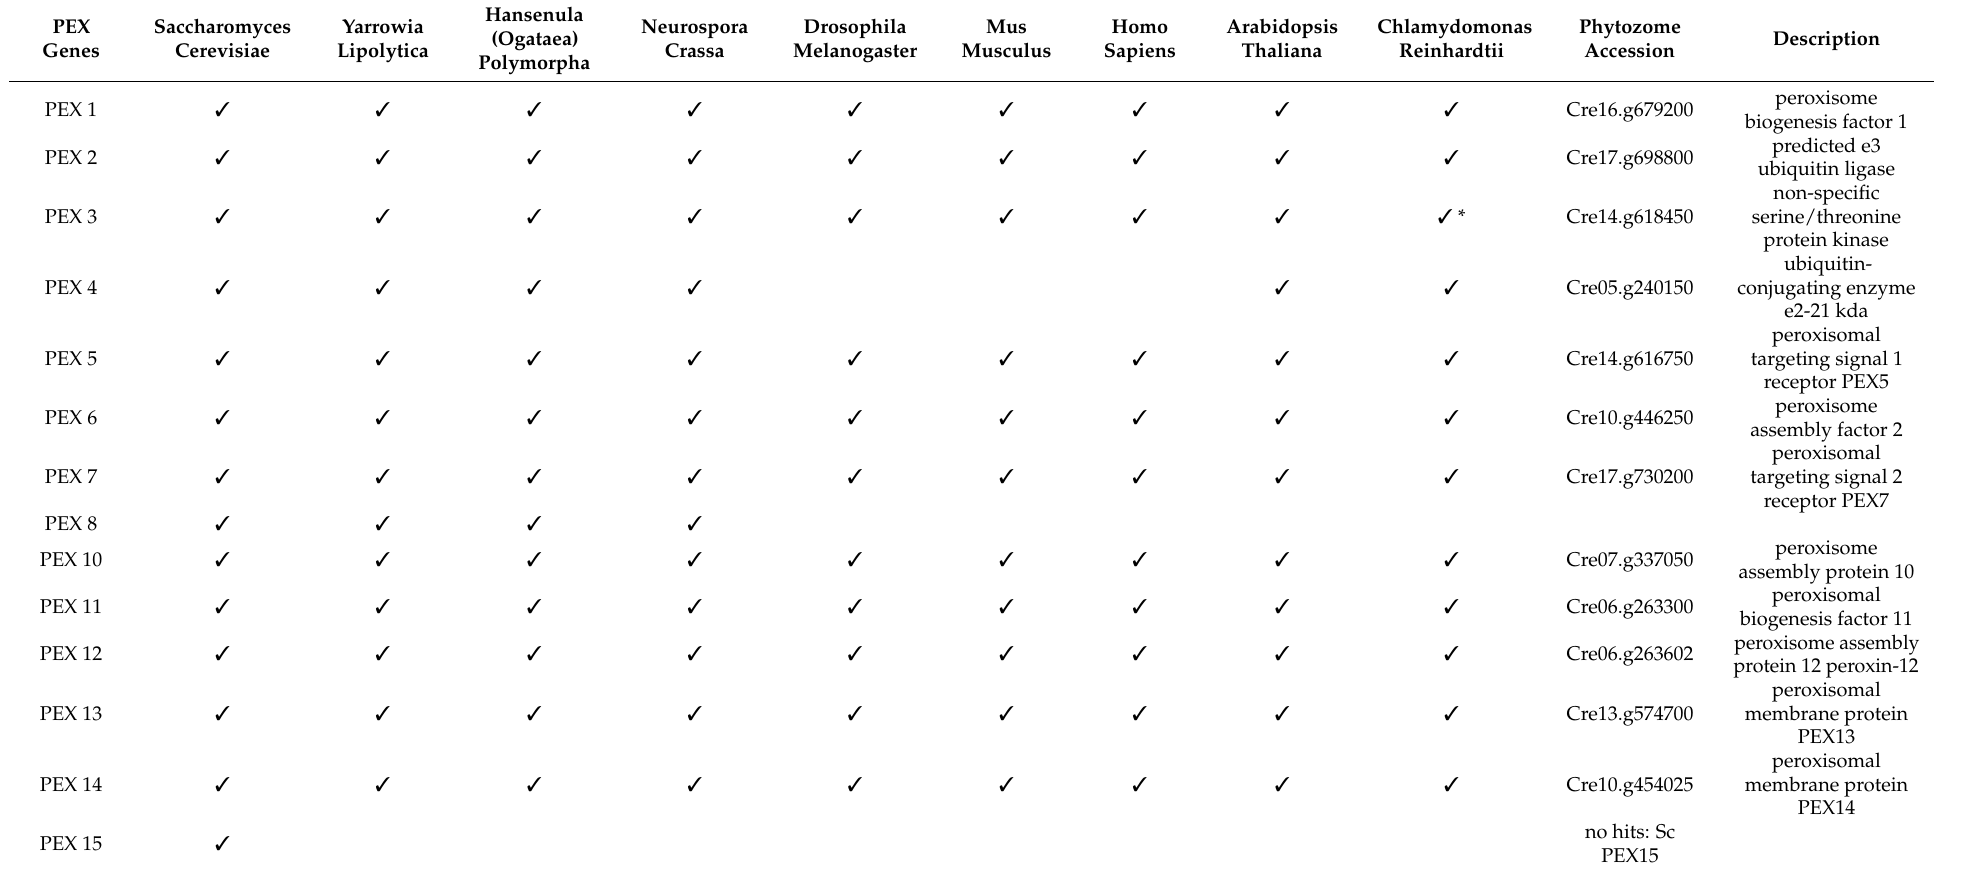
Table 2. The genome of C. reinhardtii contains a complete set of peroxisome biogenesis genes. * Hit derived from At PEX3-1 BLAST against Chlorophyceae in the NCBI database identified Vocar.0001s1462.1, the gene in Volvox carteri . A BLAST search with this gene against Cr identifies Cre14.g618450. Yl PEX9 is a homolog of PEX26 from other organisms. ** Farr é et al. 2017, PEX36 homolog of PEX16 in Komagataella phaffii (formerly Pichia pastoris ) but absent from S. cerevisiae. *** Function as PEX17 questioned by [26]. No hits in Cr for At 4g18197, At PEX17, was renamed purine permease 7 (PUP7) and is likely not an orthologue of Sc PEX17.